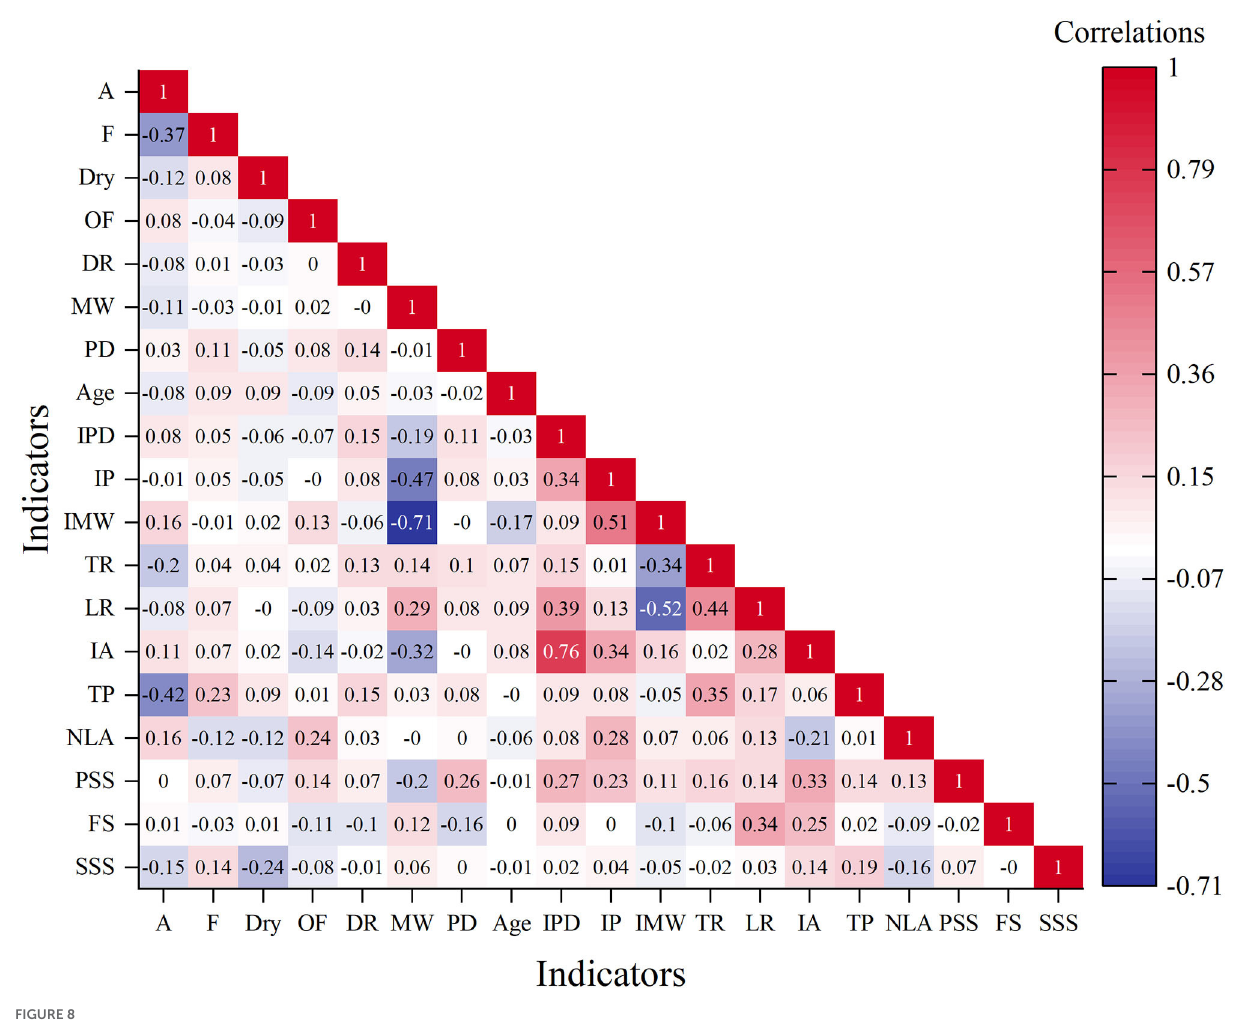
FIGURE8 Correlation between evaluation